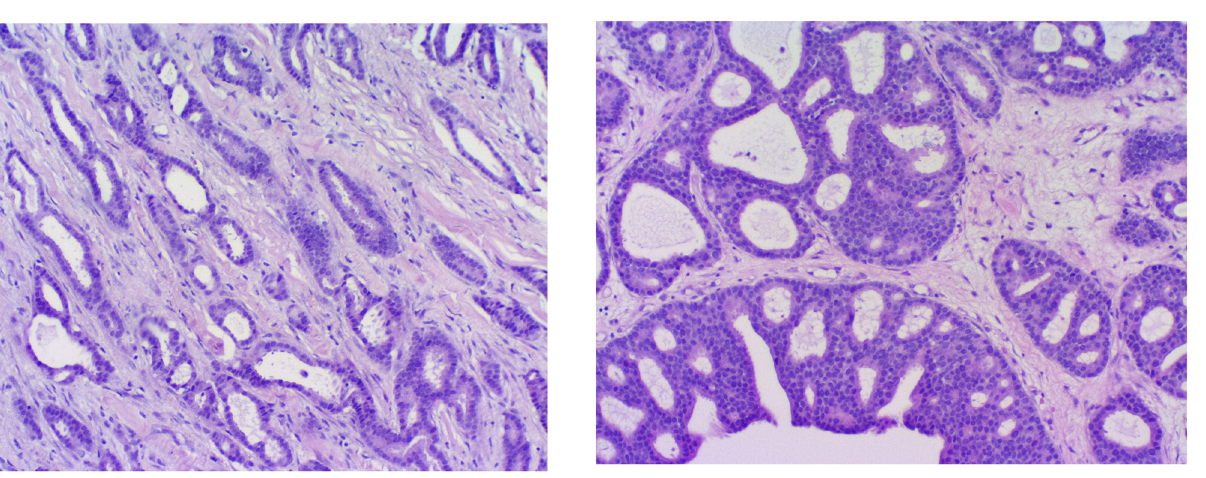
Figure 5. Breast cribriform ductal carcinoma in situ (DCIS) (H&E stain, X200 magnification).